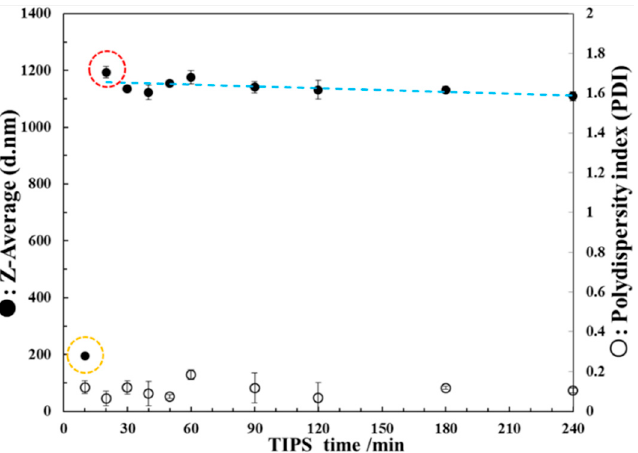
Figure 4. Z-average particle diameter and polydispersity index of PEI micro or nanoparticles in the PEI/DMSO suspension at different time points. The Z-average particle diameter is about 200 nm after TIPS for 10 min as shown in orange circle. The PEI/DMSO suspension was in the stage of rapid particle growth before 20 min, and reaching the maximum at 20 min as shown in red circle.